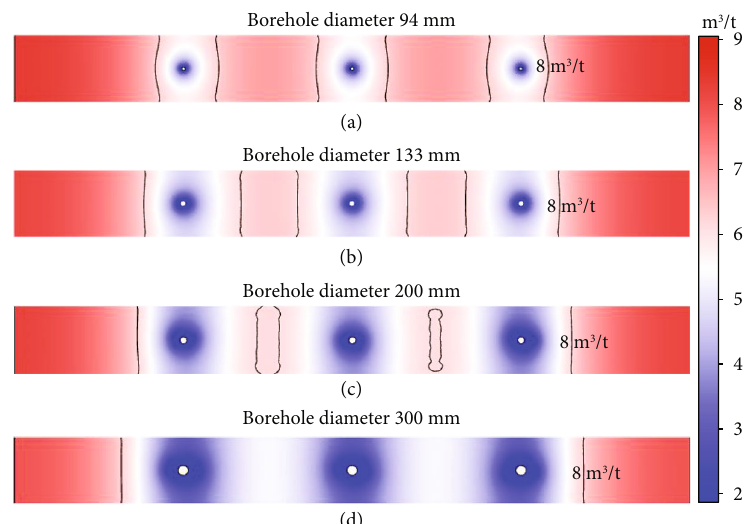
Figure 11: Gas content in soft coal seam after di ff erent borehole diameters (120 days).